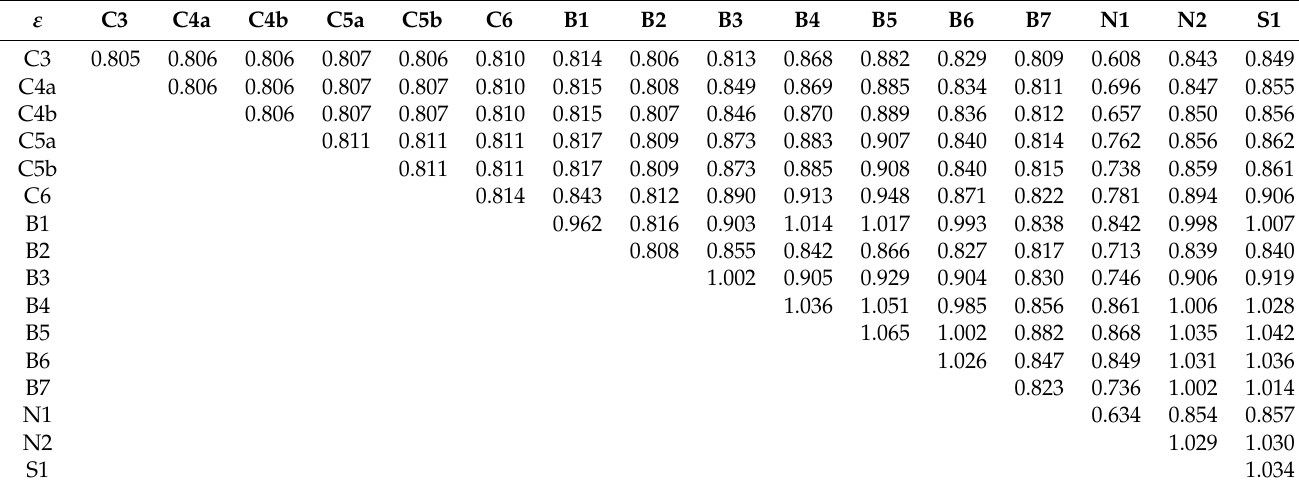
Table 4. Force field parameter ε .